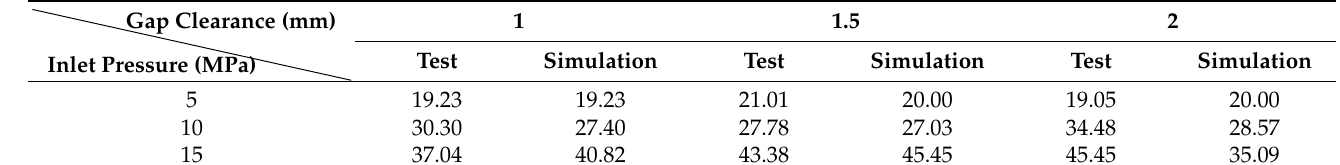
Table 7. Frequencies of cavitation surge for suction cup- θ 20 (unit: Hz).